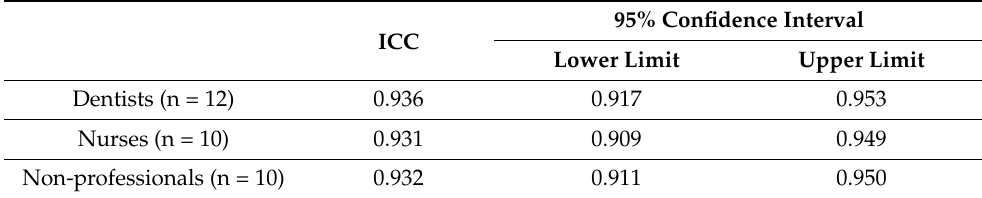
Table 1. Results of the intraclass coefficient (ICC).